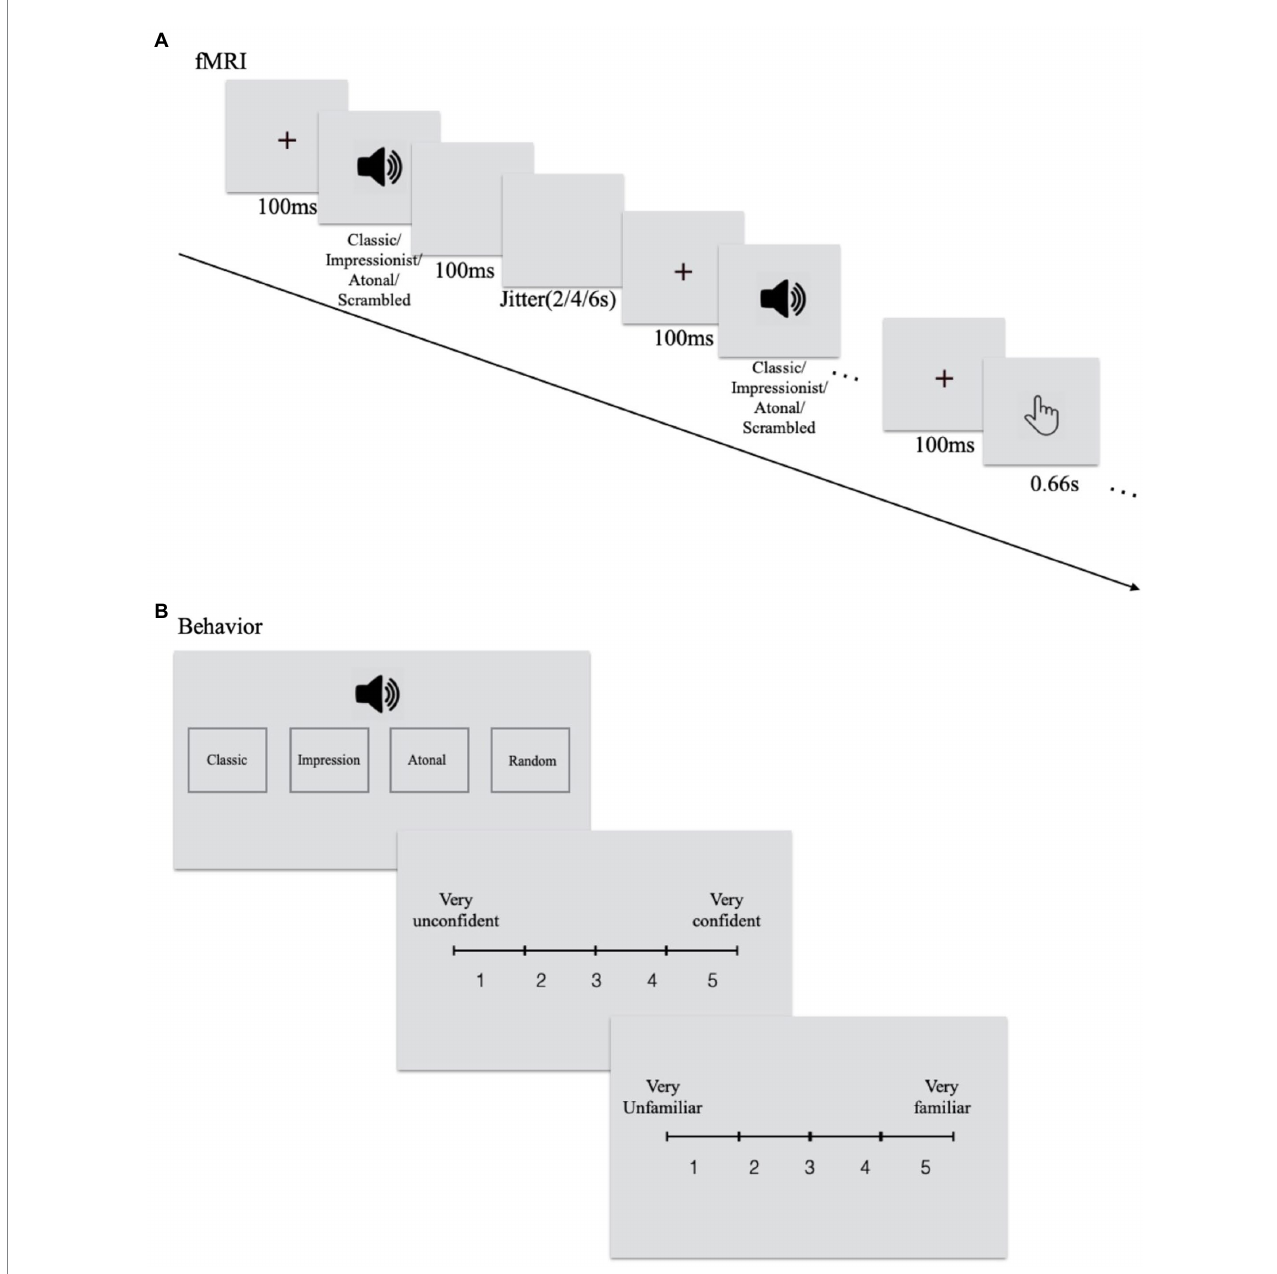
FIGURE 1 Experimental procedure for (A) the upper panel is fMRI and (B) the lower panel is behavioral